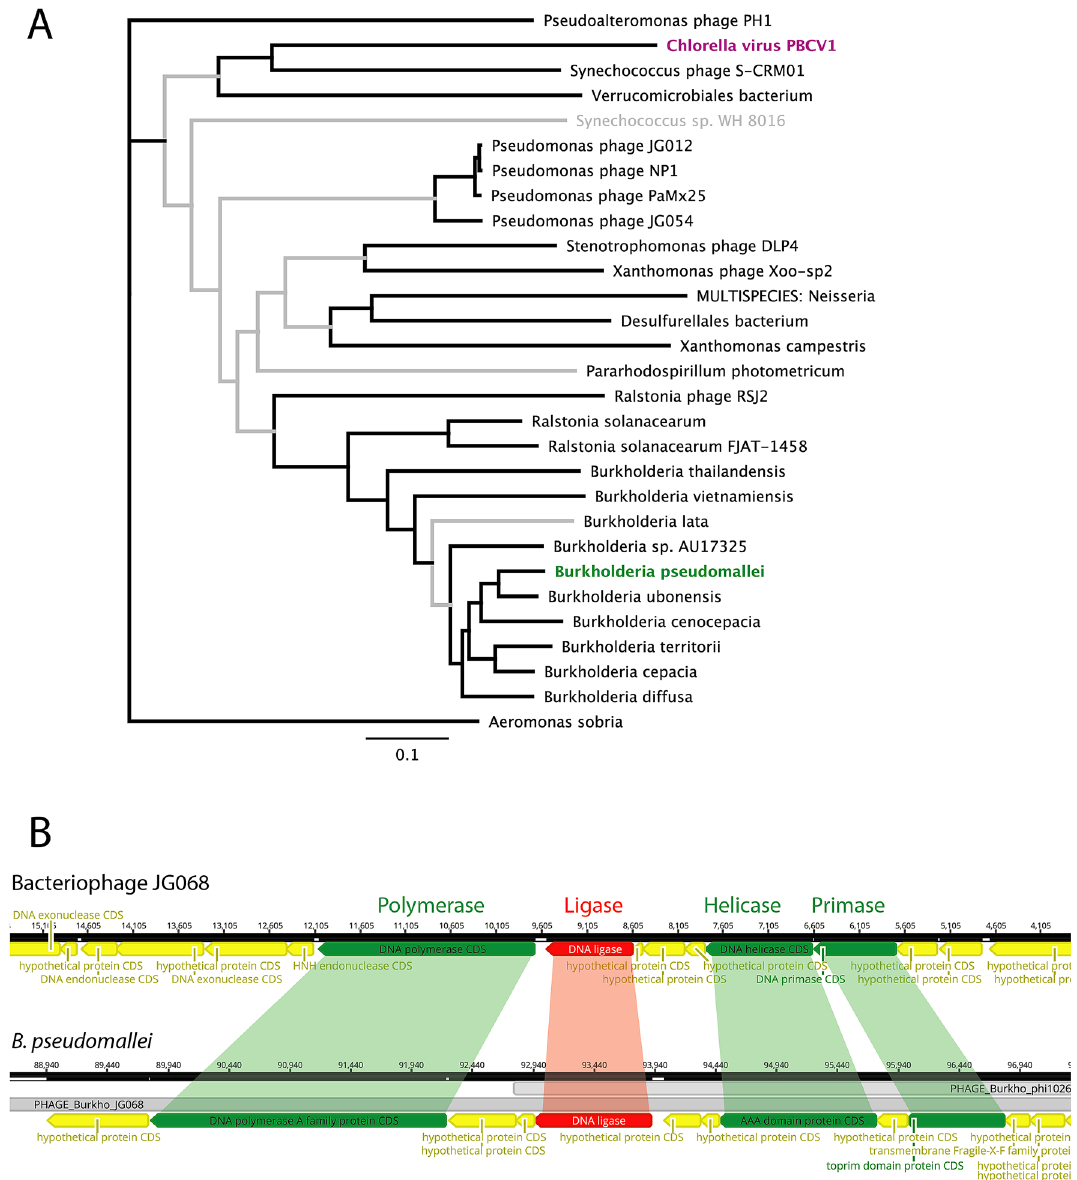
Figure 5. ( A ) Neighbor-Joining consensus tree for amino acid sequences of Bsp-lig homologs with Bsp-lig highlighted in green and ChlV-lig in magenta. Branches with > 50% consensus support are boldened in black. Sequence identifiers for ligases are given in Supplementary Table 2. ( B ) Genomic context of Bsp-lig and its homolog in bacteriophage JG068. Adjacent DNA processing genes with high similarity are highlighted in green. Bacteriophage regions predicted in B. pseudomallei are indicated in grey.